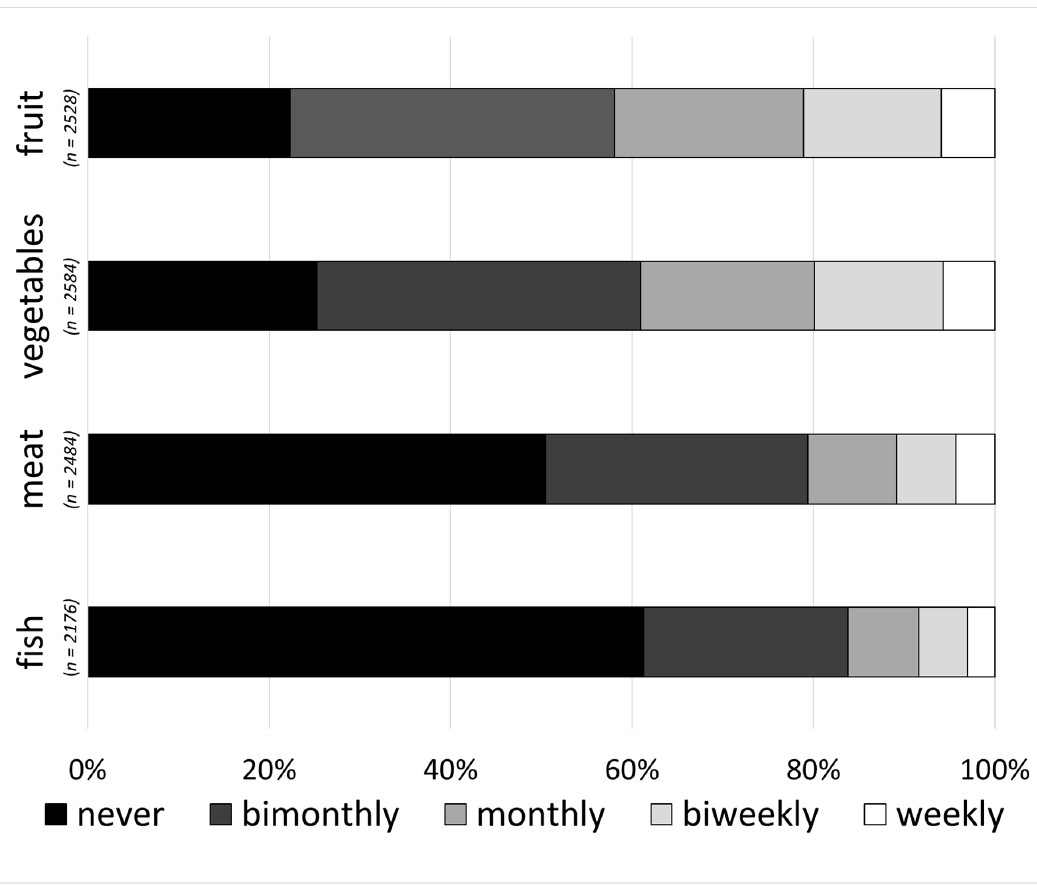
Figure 2. Frequency of respondents’ food waste for fruit, vegetables, meat and fish (multiple-choice, single-answer).